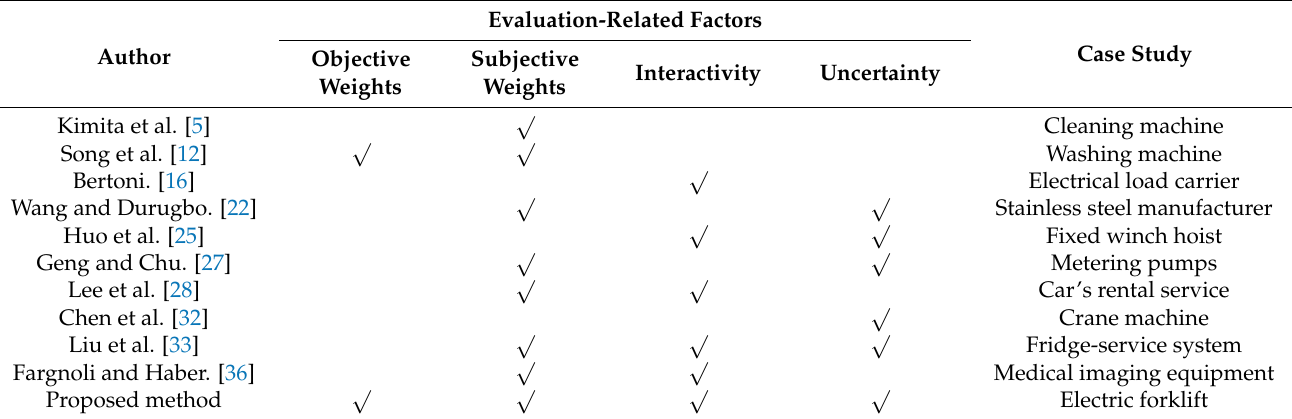
Table 1. Comparison with related literature involving PSS design